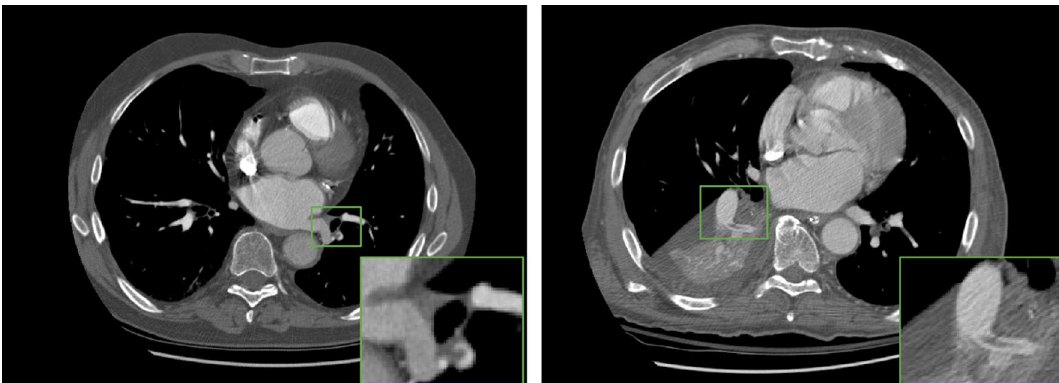
Figure 3. Two selected axial CT images of the chest from two separate patients with positive diagnosis of PE. The left CT scan demonstrates a left lower lobe posterolateral basal segmental artery filling defect consistent with a pulmonary embolism. The CT scan on the right panel demonstrates a small elongated filling defect bridging across the segmental arteries of the right lower lobe consistent with a segmental pulmonary embolism, in addition to surrounding collapse of the right lower lobe. The vision-only model yielded false- negative predictions for both cases, but the fusion model correctly predicted both as